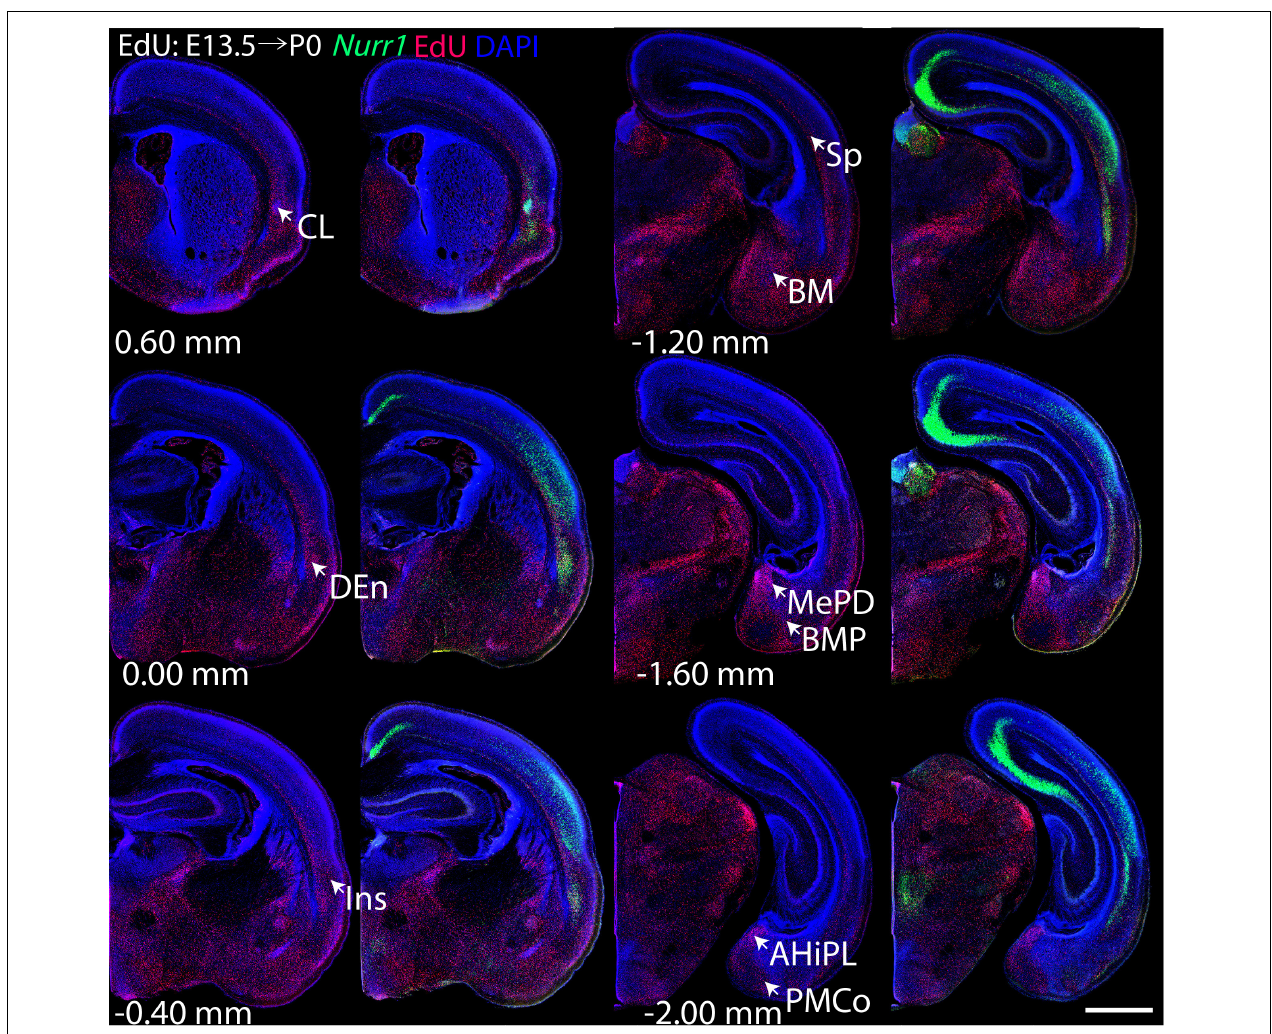
FIGURE 5 | Overview of EdU labeling on E13.5 with Nurr1 FISH on P0. White arrows indicate the EdU labeled regions. CL, claustrum, DEn, dorsal endopiriform nucleus, Ins, insular cortex, Sp, subplate, BM, basomedial amygdaloid nucleus, MePD, medial amygdaloid nucleus, posterodorsal part, BMP, basomedial amygdaloid nucleus, posterior part, AHiPL, amygdalohippocampal area, posterolateral, PMCo, posteromedial cortical amygdaloid area. Numbers below sections indicate the bregma coordinate. N = 3 rats. Scale bar = 1